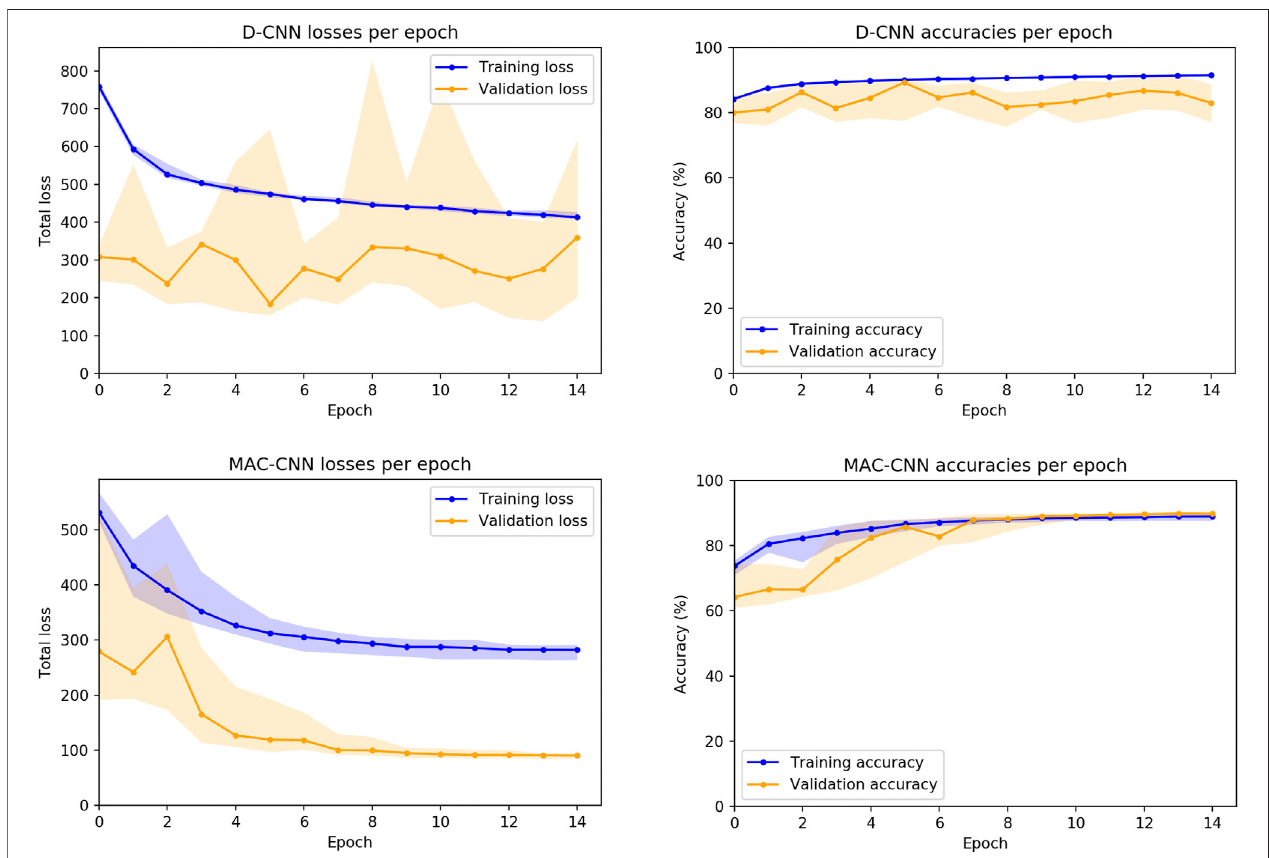
FIGURE 5 | D-CNN and MAC-CNN loss and accuracies per epoch, sampled over 30 pretrained networks with random initializations of the fully connected layers. Thelinesrepresentthemedianloss/accuracy,andtheshadedregionsrepresentlosses/accuraciesbetweenthe25thand75thpercentileforeachepoch.Asresultsfrom the validation and testing sets trend very closely, only results from the training and validation sets are